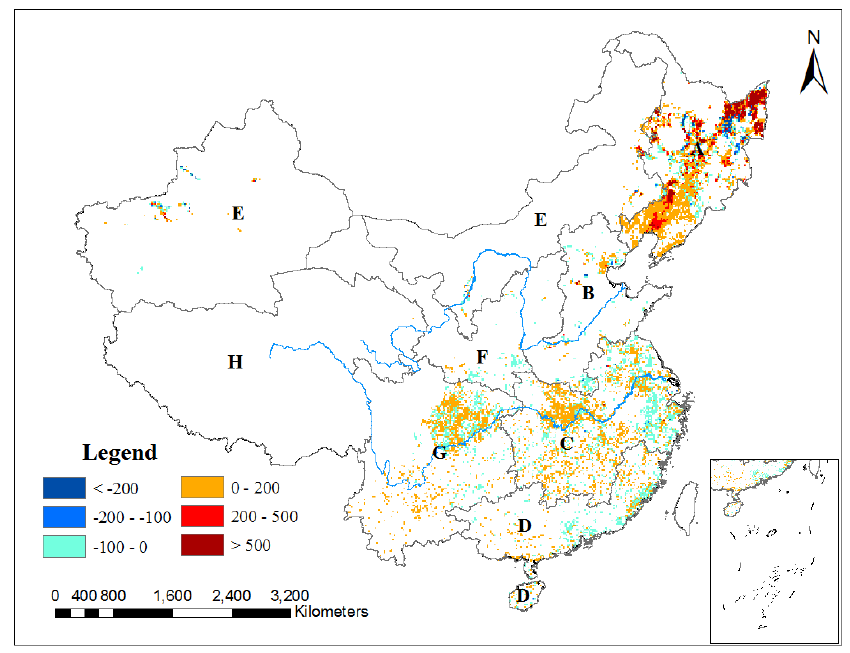
Figure 7. Changes in CR affected by interconversion of paddy fields and dry land from E 1990 to 2010 (t/10 km 2